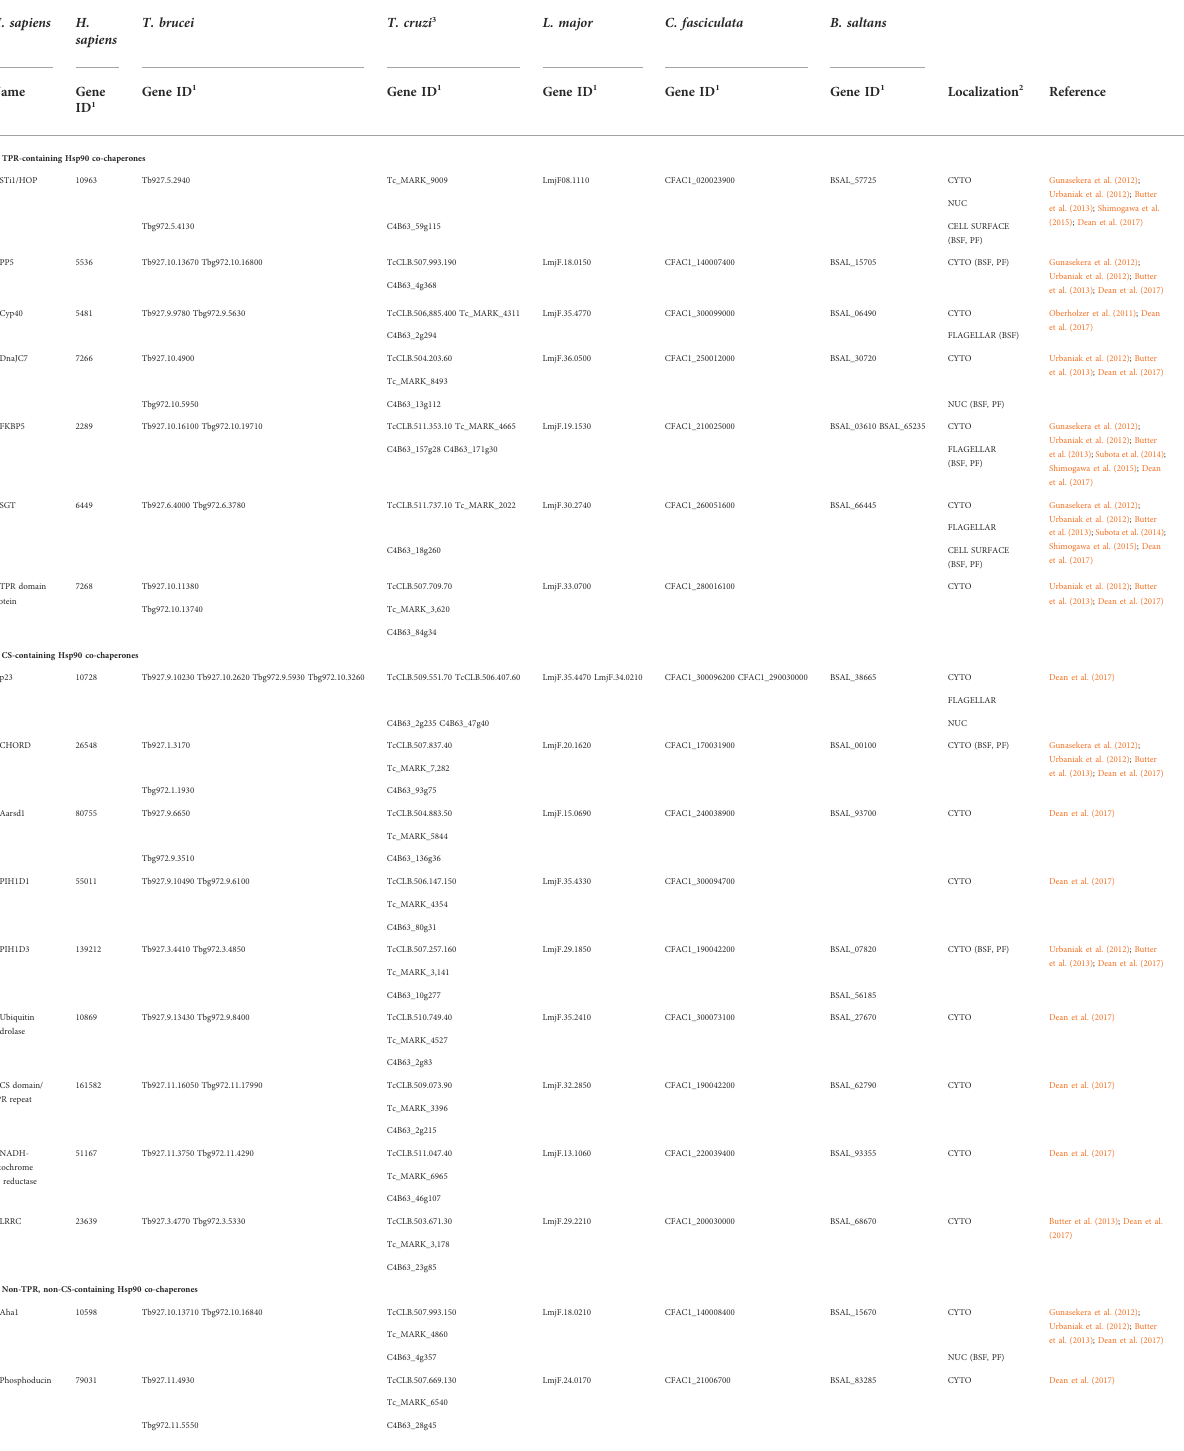
TABLE 2 HSP83/HSPC co-chaperones from Trypanosoma brucei with their putative orthologues in T. cruzi , L. major , C. fasciculata , B. saltans , and H. sapiens . H. sapiens H.